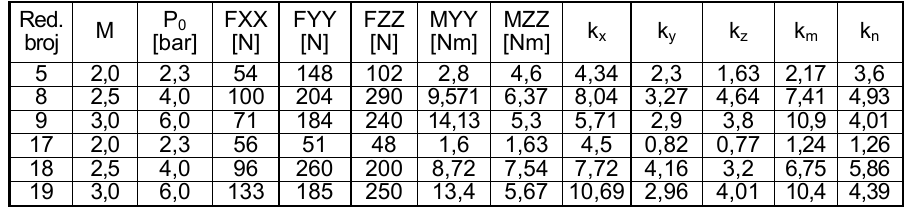
Pregled sakupljenih podataka za merenje prelaznih optere ć enja na Modelu